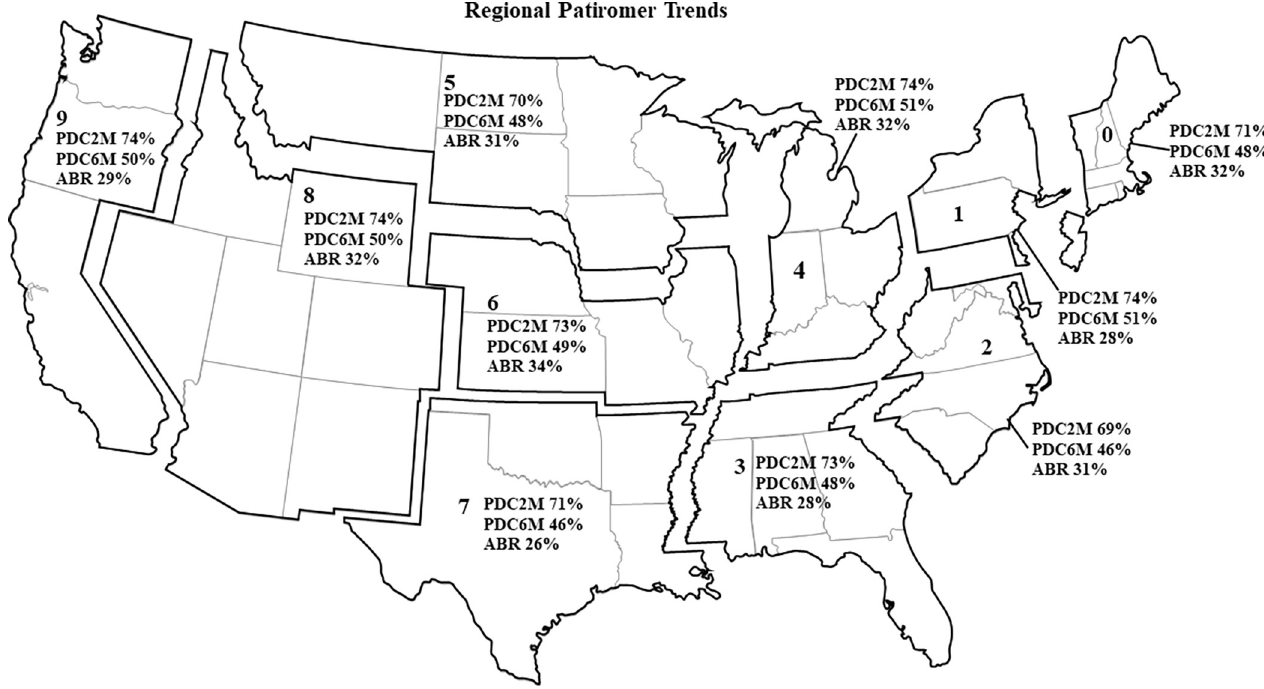
Fig 1. Patiromer prescribing, adherence, and abandonment rates by region. n = patiromer patients (% total). Numbers 0–9 indicate the first digit of a region’s ZIP code. Abbreviations: ABR, abandonment rate; PDC2M, 60-day proportion of days covered; PDC6M, 6-month proportion of days covered. Adapted from iStock image. https://www.istockphoto.com/vector/united-states-of-america-map-us-blank-map-template-outline-usa-map-background- gm1301588831-393587962.